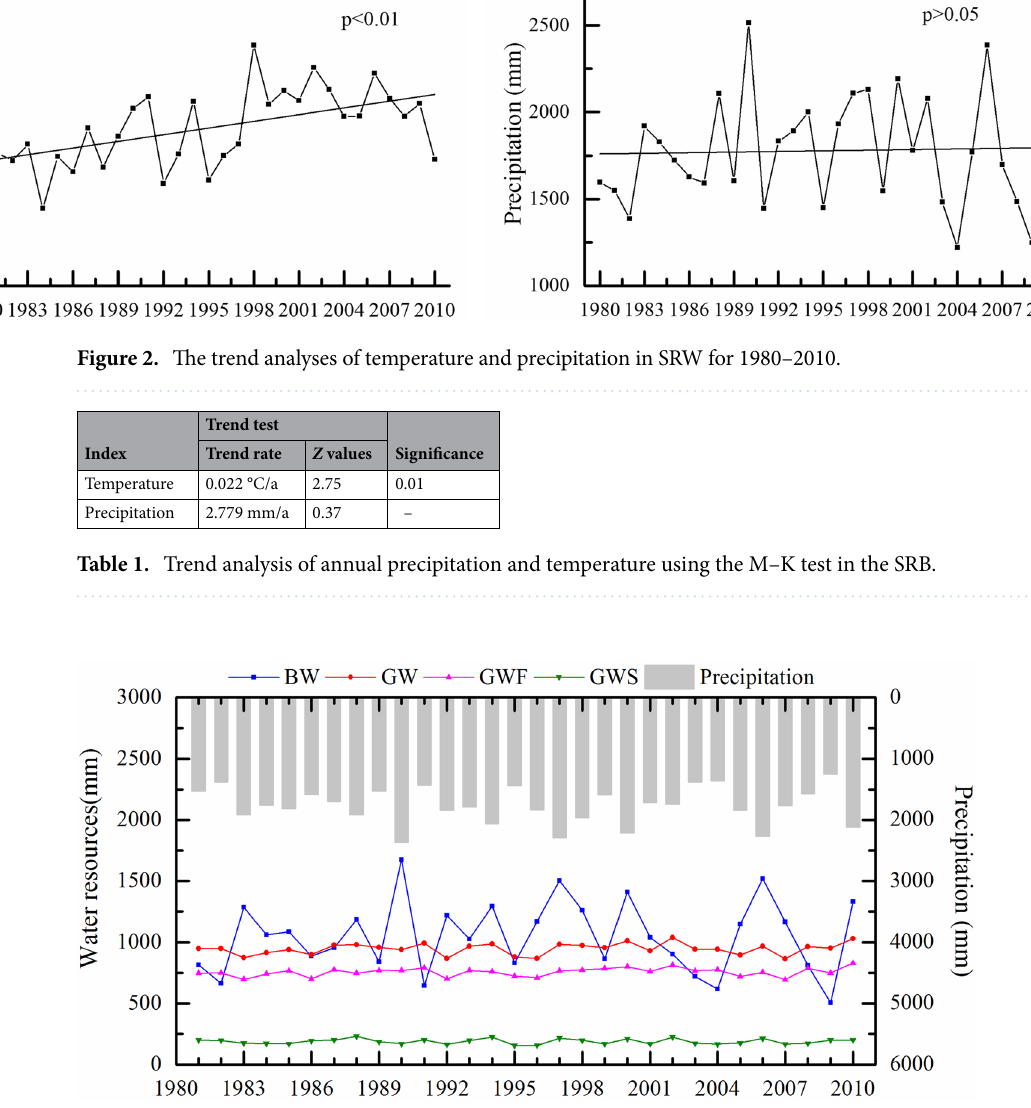
Figure 3. Annual variation of BW and GW resources in the SRB for